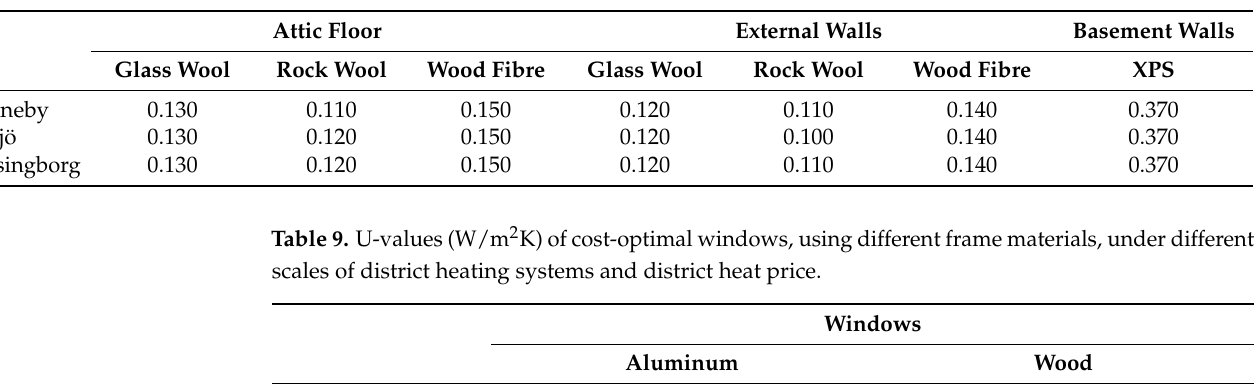
Table 8. U-values (W/m 2 K) of cost-optimal extra insulation, using different materials, under different scales of district heating systems and district heat price.